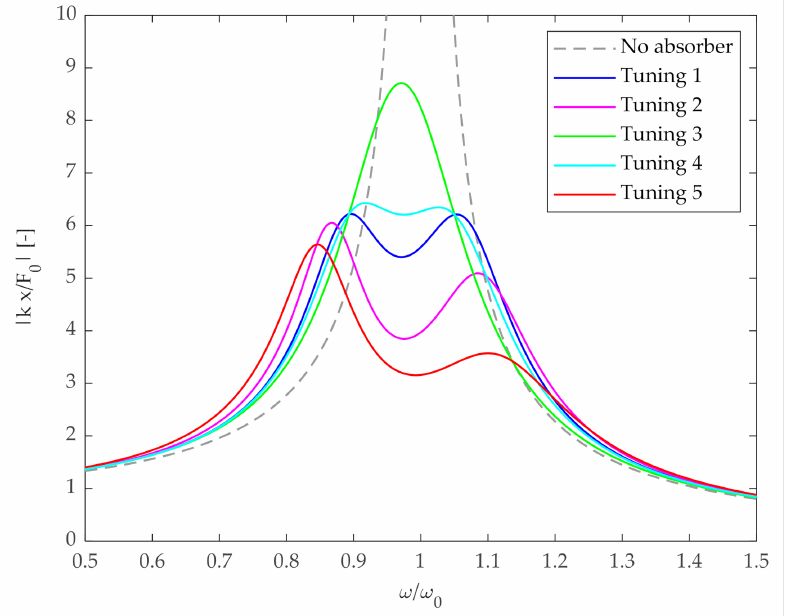
Figure 3. Amplitude of the response of the primary system: comparison of different tunings of the ATMD (normalized by k ).